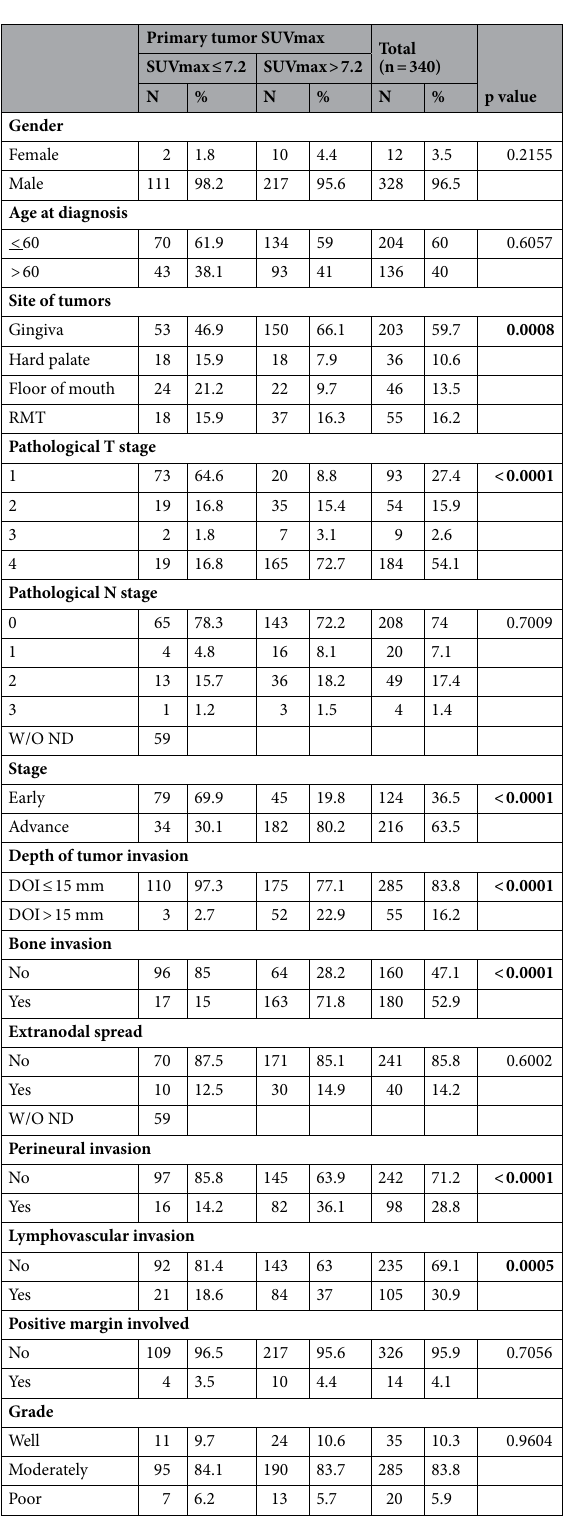
Table 2. Univariate analyses: tSUVmax ≤ 7.2 versus tSUVmax > 7.2. p value by Chi-squared test. W/O ND without neck dissection, RMT retromolar trigone, Early stage AJCC stage I and II, Advanced stage stage III